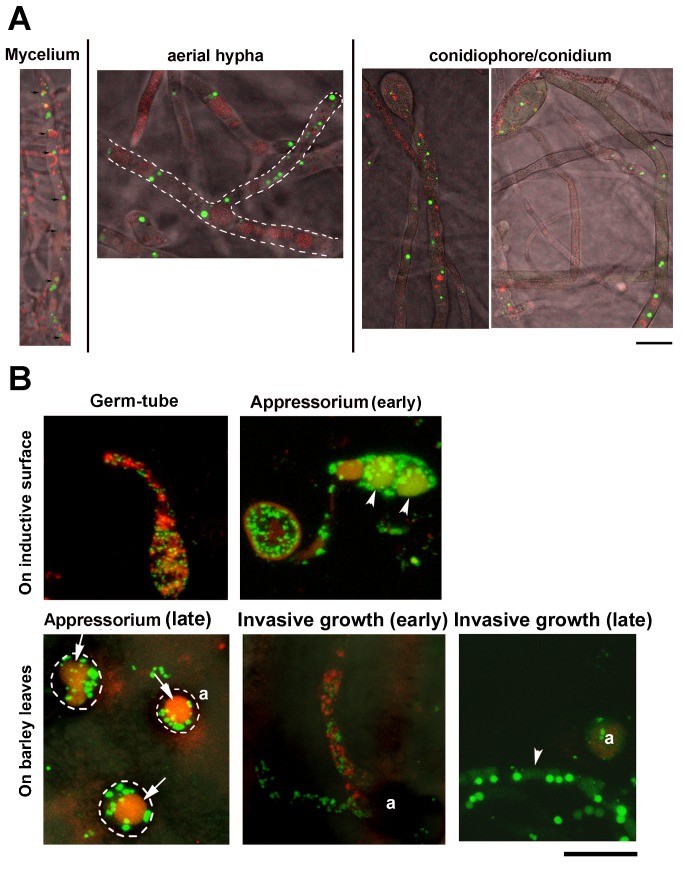
Analysis of pexophagy during M. oryzae conidiation and pathogenic development.(A) Confocal microscopy of conidiating cultures grown on PA medium, from M. oryzae GFP-SRL/RFP-Atg8 strain shows the lack of pexophagy therein during asexual development. Images shown are representative of the developmental stage depicted by the majority of vegetative mycelia, aerial hyphae or conidiophores. Dashed outline depicts aerial hyphae and its connecting mycelium. Scale bar equals 5 micron. (B) Pexophagy is naturally induced during appressorium formation and function. Conidia from the GFP-SRL/RFP-Atg8 strain were inoculated on inductive surface and visualized by confocal microscopy, at the indicated stages of germination (2-4 hpi), appressorium initiation (5-8 hpi) and appressorium maturation (14-16 hpi). For the assessment of in
planta differentiation, conidia were inoculated on barley leaf explants and visualized by confocal microscopy at the indicated stages. Arrowheads denote vacuoles containing GFP-SRL (peroxisomes). Arrows denote vacuoles without GFP-SRL. Scale bar equals 10 micron.